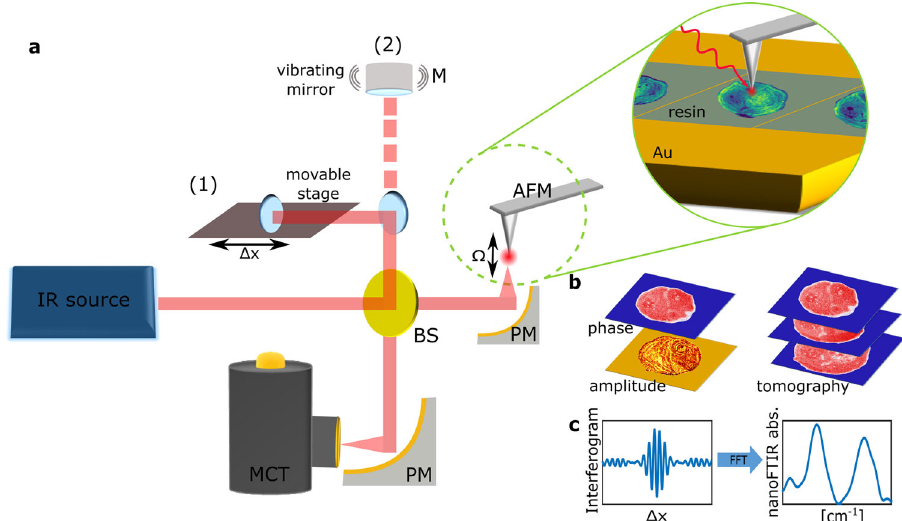
Fig. 1 Operating modes of IR nanoscopy in an asymmetric Michelson interferometer scheme. a IR radiation, either broadband fs laser for nanoFTIR or QCL for sSNOM, is guided through a beamsplitter (BS) and focused on an oscillating AFM tip via a parabolic mirror (PM). For nanoFTIR (1), the reference arm mirror is mounted on a movable stage. In sSNOM mode (2), the reference arm is equipped with piezo-driven mirror vibrating with frequency M. The scattered light from the tip is recombined with the re fl ected light from the reference arm at the BS, focused on a mercury-cadmium-telluride (MCT) detector, and fed to a lock-in ampli fi er. b Simultaneously to AFM imaging, the demodulated sSNOM scattering amplitude and phase are recorded. sSNOM tomography is performed by imaging of serial sections. c The detected interferogram is demodulated at sidebands n Ω ± mM for harmonics n and m of the tip ’ s resonance frequency Ω and the mirror ’ s vibration frequency M, respectively. Fast Fourier transformation (FFT) of the interferogram is used to obtain nanoFTIR spectra.